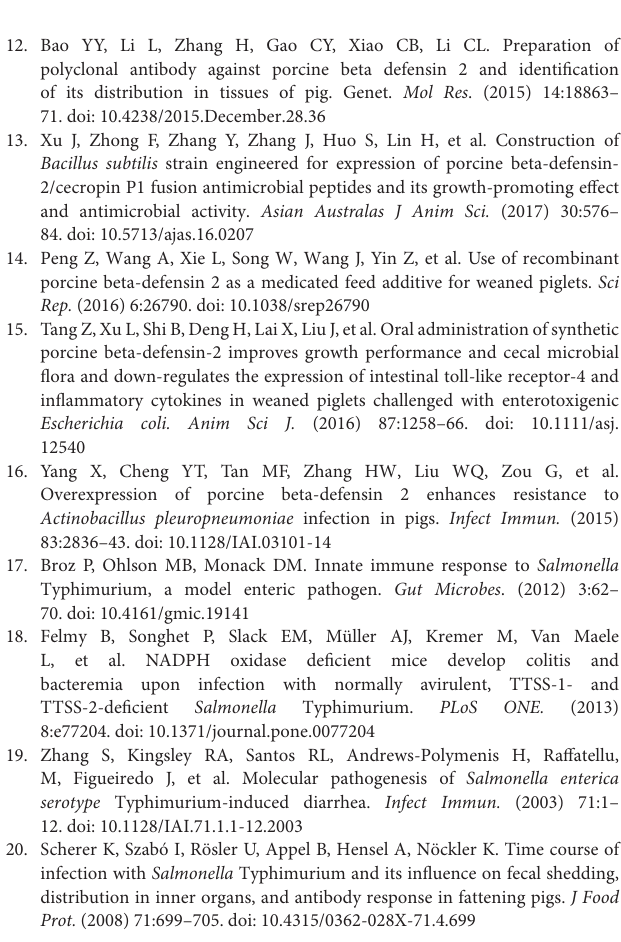
Figure S2 | Effect of PBD-2 on the viability of RAW 264.7 cells. Cell proliferation rate was detected by MTT assay. RAW 264.7 cells were incubated with PBD-2 at 1, 5, and 10 µ g/ml alone or together with LPS (1 µ g/ml). Data are represented as means ± SD ( n = 6 each group). Figure S3 | PBD-2 expressing RAW 264.7 cells were confirmed through indirect IFA by using the antiserum of PBD-2 (A) and qRT-PCR by using the PBD-2 detection primers (B) . Figure S4 | Effects of PBD-2 on ERK, p38, and JNK signaling pathways. Cells were treated with LPS for 30min with or without various concentrations of PBD-2. The expression levels of ERK, p-ERK, p38, p-p38, JNK, p-JNK, and β -actin were examined by Western blot (A) . The signal intensity of each band was quantified (B–D) . Figure S5 | Effect of PBD-2 on the endotoxin activity. Endotoxin activity was detected via a LAL assay. Cells were treated with LPS (1 µ g/ml) with or without various concentrations of PBD-2 (1, 5 and 10 µ g/ml). Data are represented as means ± SD (n = 6 each group). Figure S6 | Interaction of PBD-2 with LPS detected by ITC. PBD-2 was placed in a syringe (concentration = 0.75mM) and LPS was added in the calorimeter cell (concentration = 0.050mM). PBS was placed in the calorimeter cell as a negative control. Table S1 | Assays of bacterial infection or LPS treatment of mice. Table S2 | Physiological and biochemical indexes of the blood sample from TG and WT